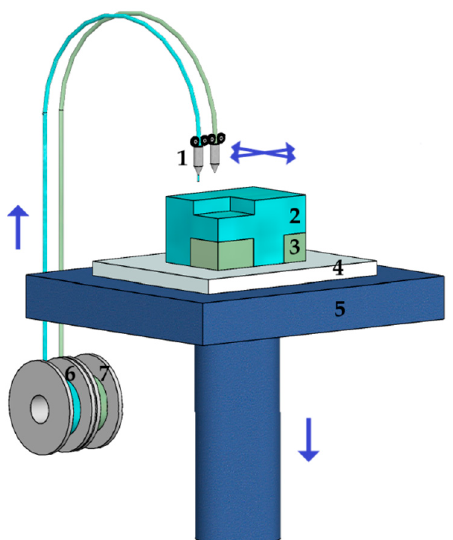
Figure 4. Fused Deposition Modeling as an Material Extrusion (ME) technology example: 1—extrusion nozzles, 2—part, 3—part supports, 4—base, 5—build platform, 6—build material spool, 7— support material spool.